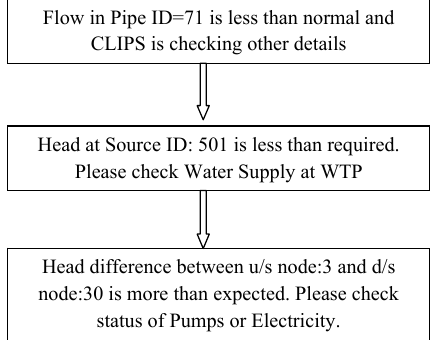
Figure 20. Messages received for addressing consumer Fig. 19. Advice/Suggestion/Warning issued by CLIPS. Fig. 20. Messages received for addressing consumer complaint